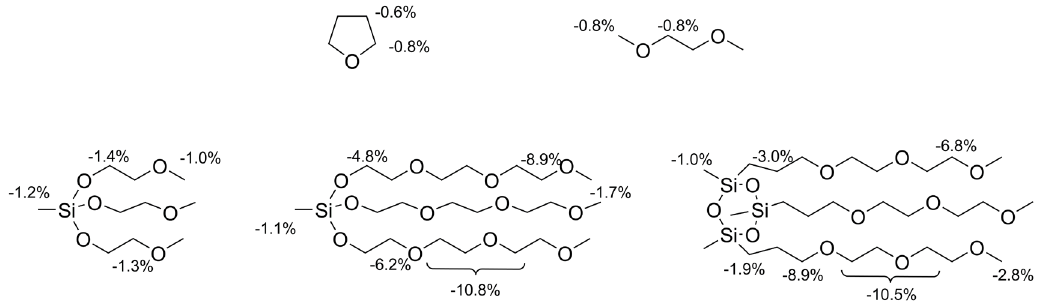
Figure 6. Observed heteronuclear NOE effects for selected ligands and model